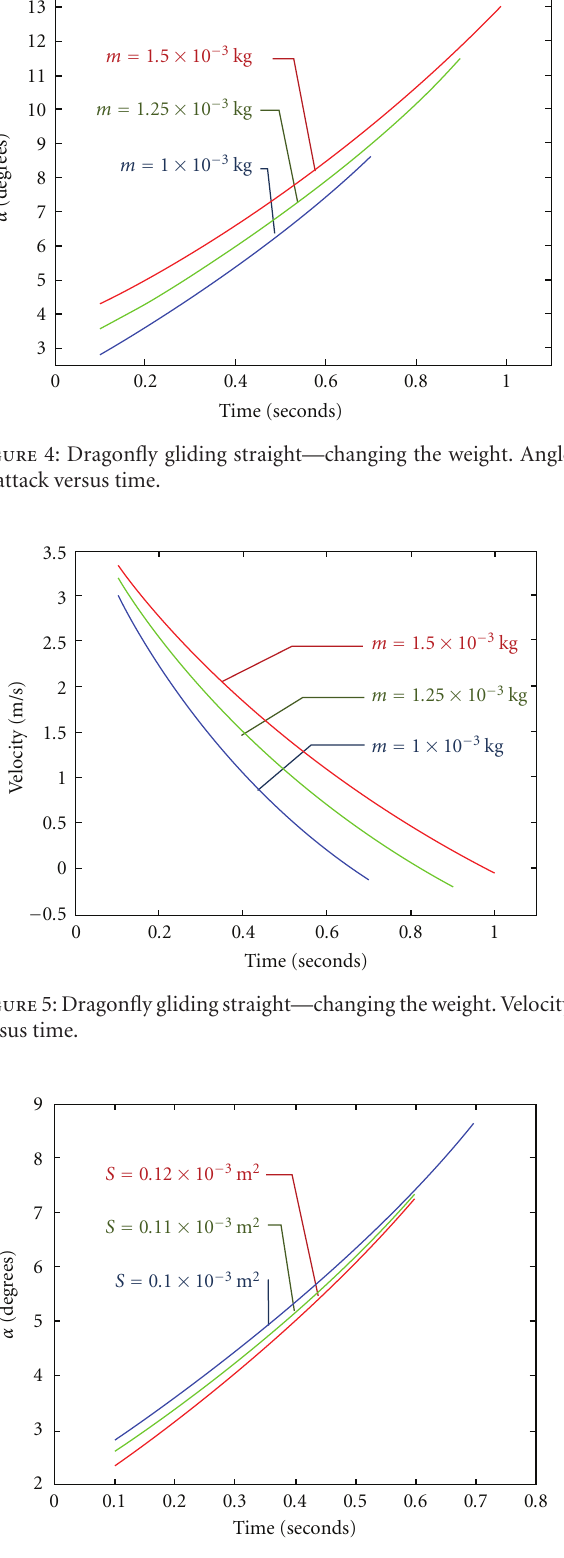
Figure 6: Dragonfly gliding straight—changing the wing area. Angle of attack versus time.